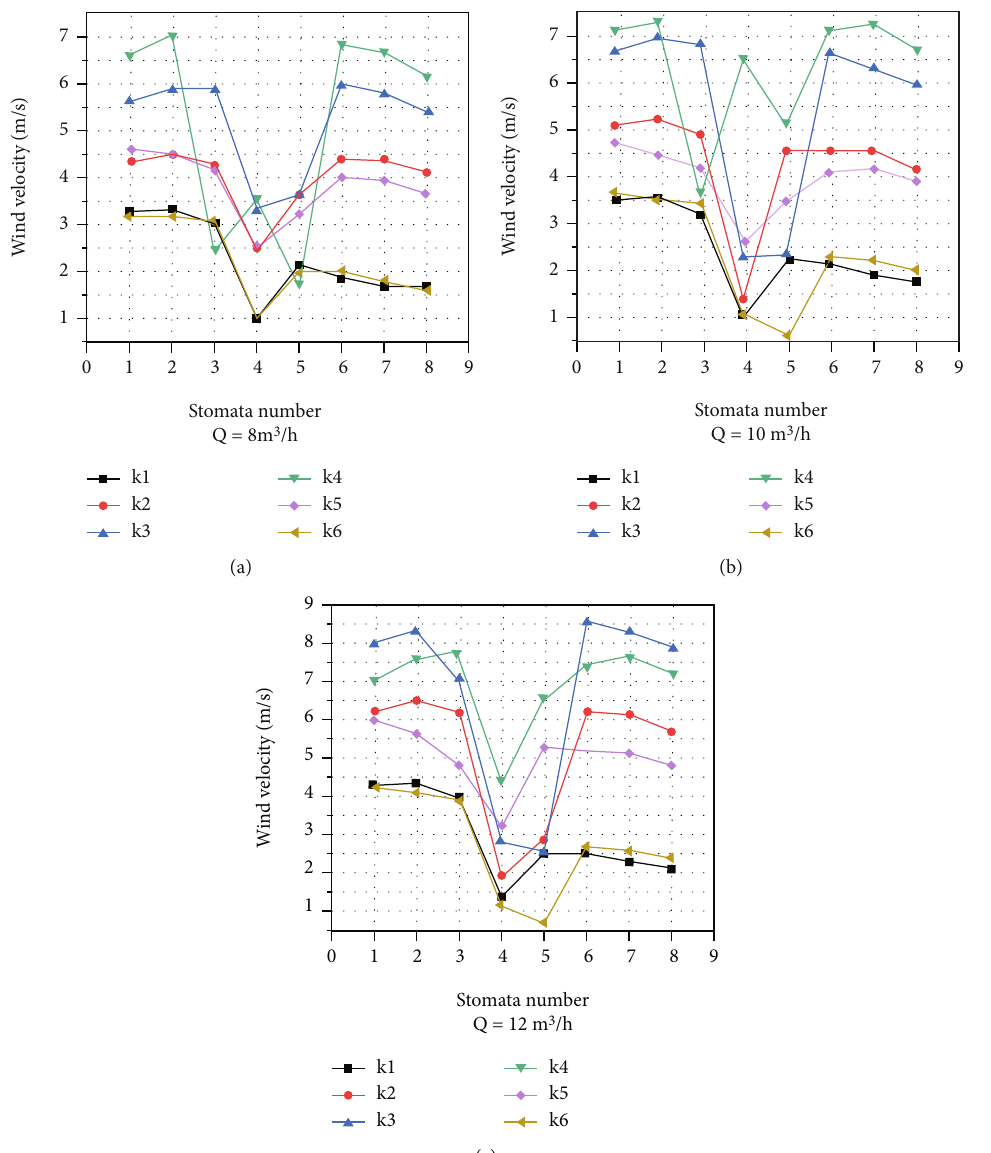
Figure 9: Stomatal wind velocity fi gure of transverse type: (a) when the ventilation rate is 8 m 3 /h, the stomatal wind speed of each pipeline; (b) when the ventilation rate is 10 m 3 /h, the stomatal wind speed of each pipeline; (c) when the ventilation rate is 12 m 3 /h, the stomatal wind speed of each